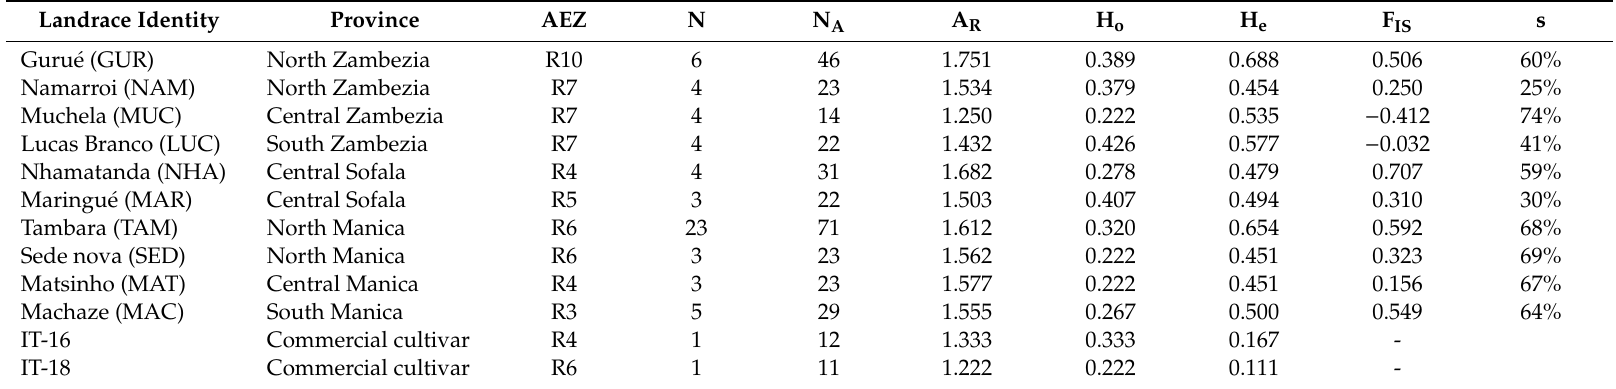
Table 2. Genetic diversity within the cowpea genotypes studied. The agro-ecological zone (AEZ), number of samples analyzed (N), total number of alleles (N A ), mean allelic richness (A R ), mean observed heterozygosity (H o ) and expected heterozygosity (H e ), inbreeding coe ffi cient (F IS ), and selfing rate (s) as a percentage are shown for each